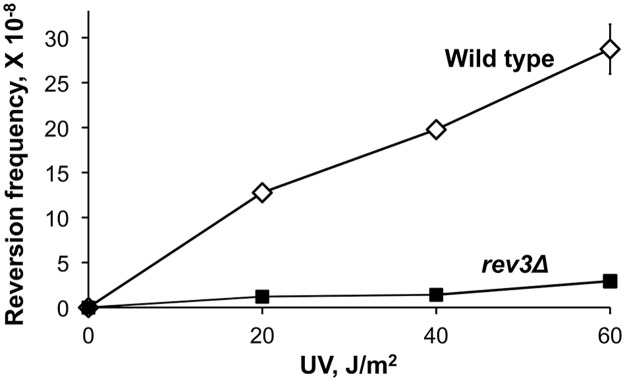
Frequency of UV-induced reversion of the ura3-G764A allele in the wild-type and Polζ-deficient (rev3Δ) strains.The data are mean frequencies for at least six determinations. Error bars are shown unless they are smaller than the plot symbol and represent standard errors.